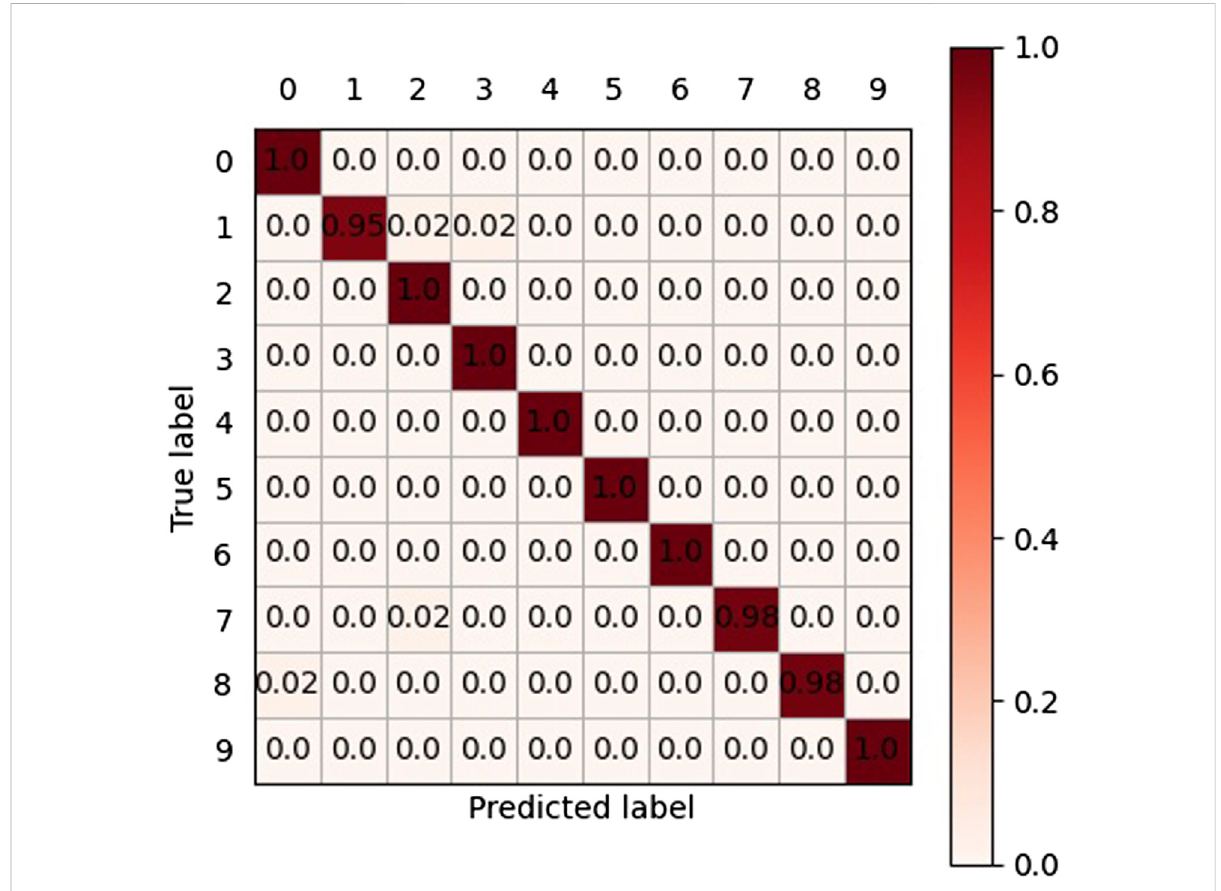
FIGURE 7 Chaotic matrixof all the samples inthetest experiment.The diagonalvaluesofthe matrix are therates ofcorrectclassi fi cations, while thenon- diagonal values are the rates of wrong classi fi cations.